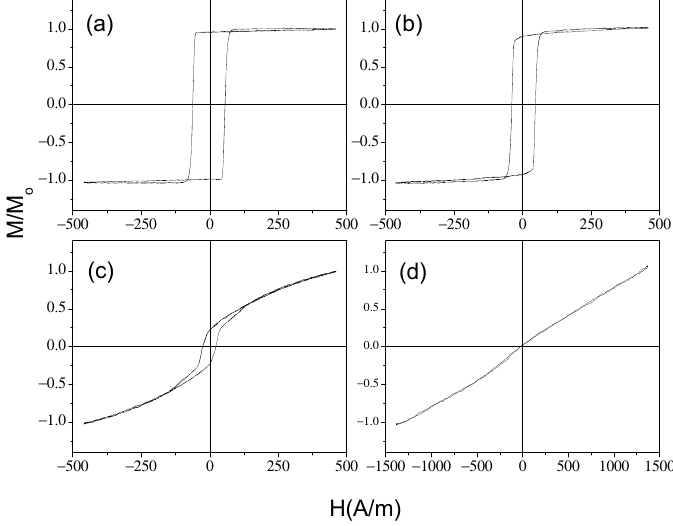
Figure 17. Hysteresis loops of as-prepared ( a ), annealed at 200 °C ( b ), 250 °C ( c ) and 300 °C ( d ) for 1 h and σ m ≈ 900 MPa Fe 75 B 9 Si 12 C 4 microwires. (Reproduced with permission from [87] Copyright © 2018, Springer Nature, Open Access).